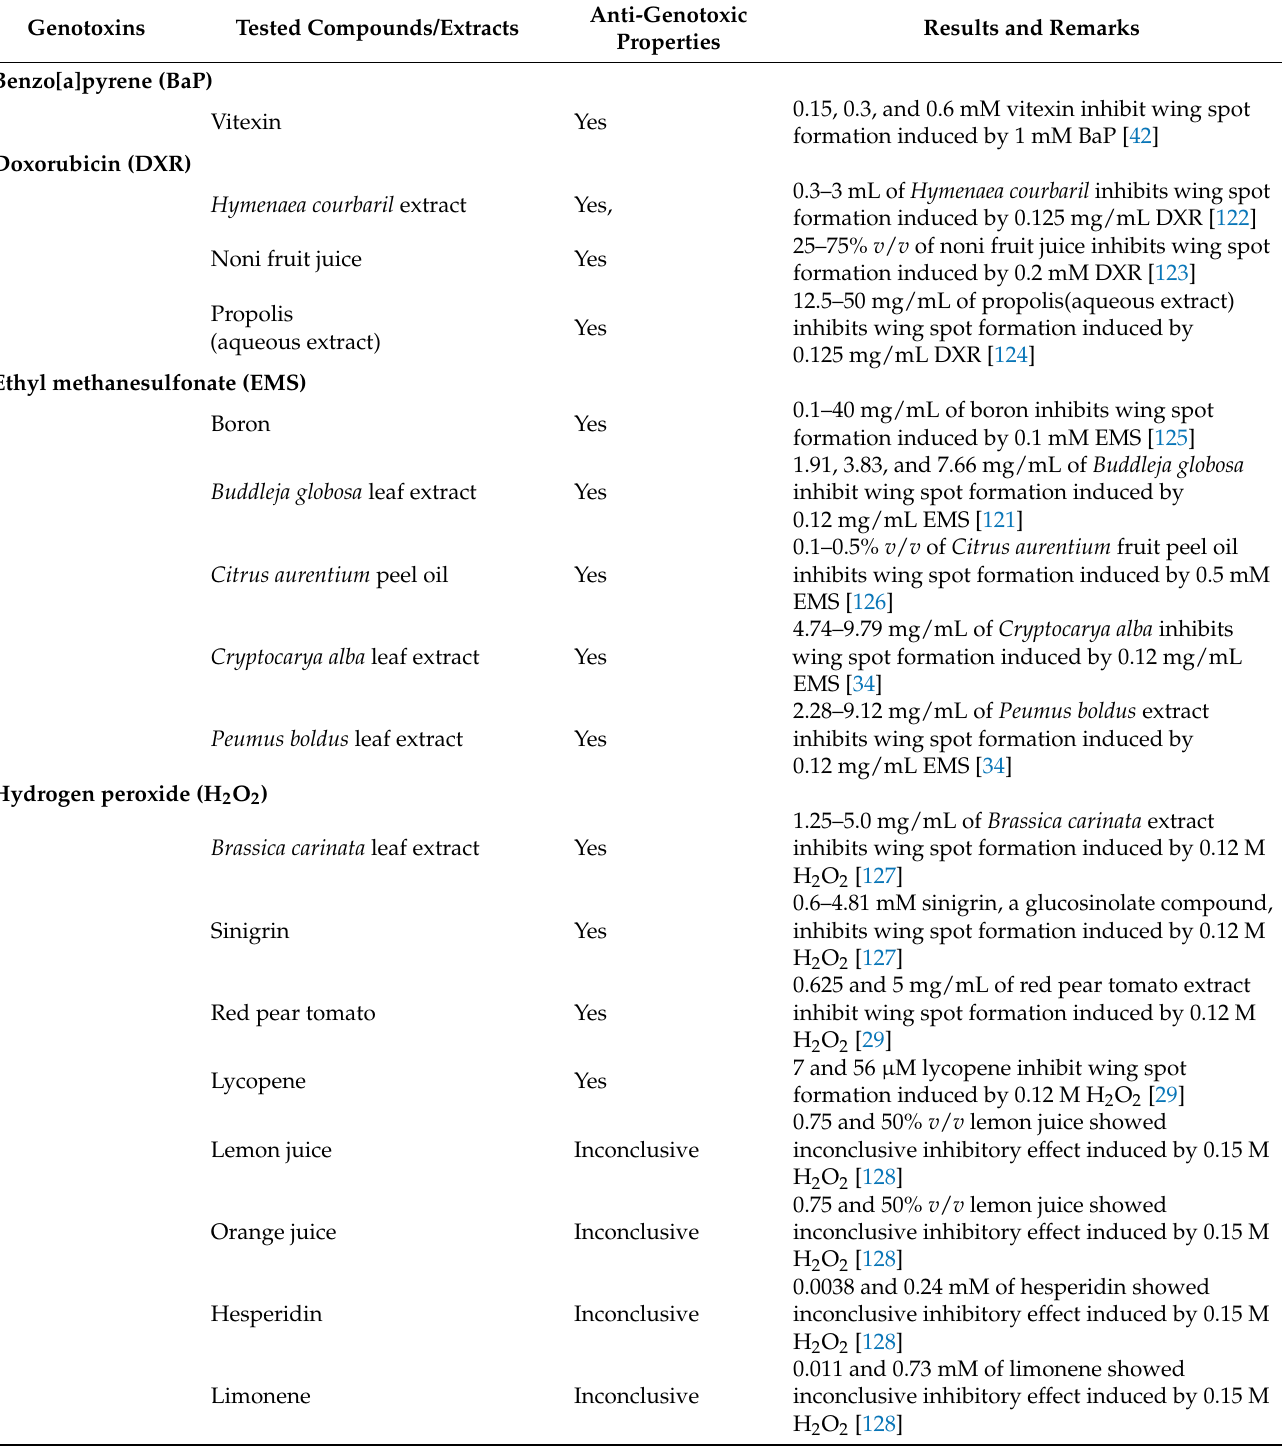
Table 7. The roles of some phytochemicals or herbal extracts against known mutagens/carcinogens using SMART assay. Genotoxins Tested Compounds/Extracts